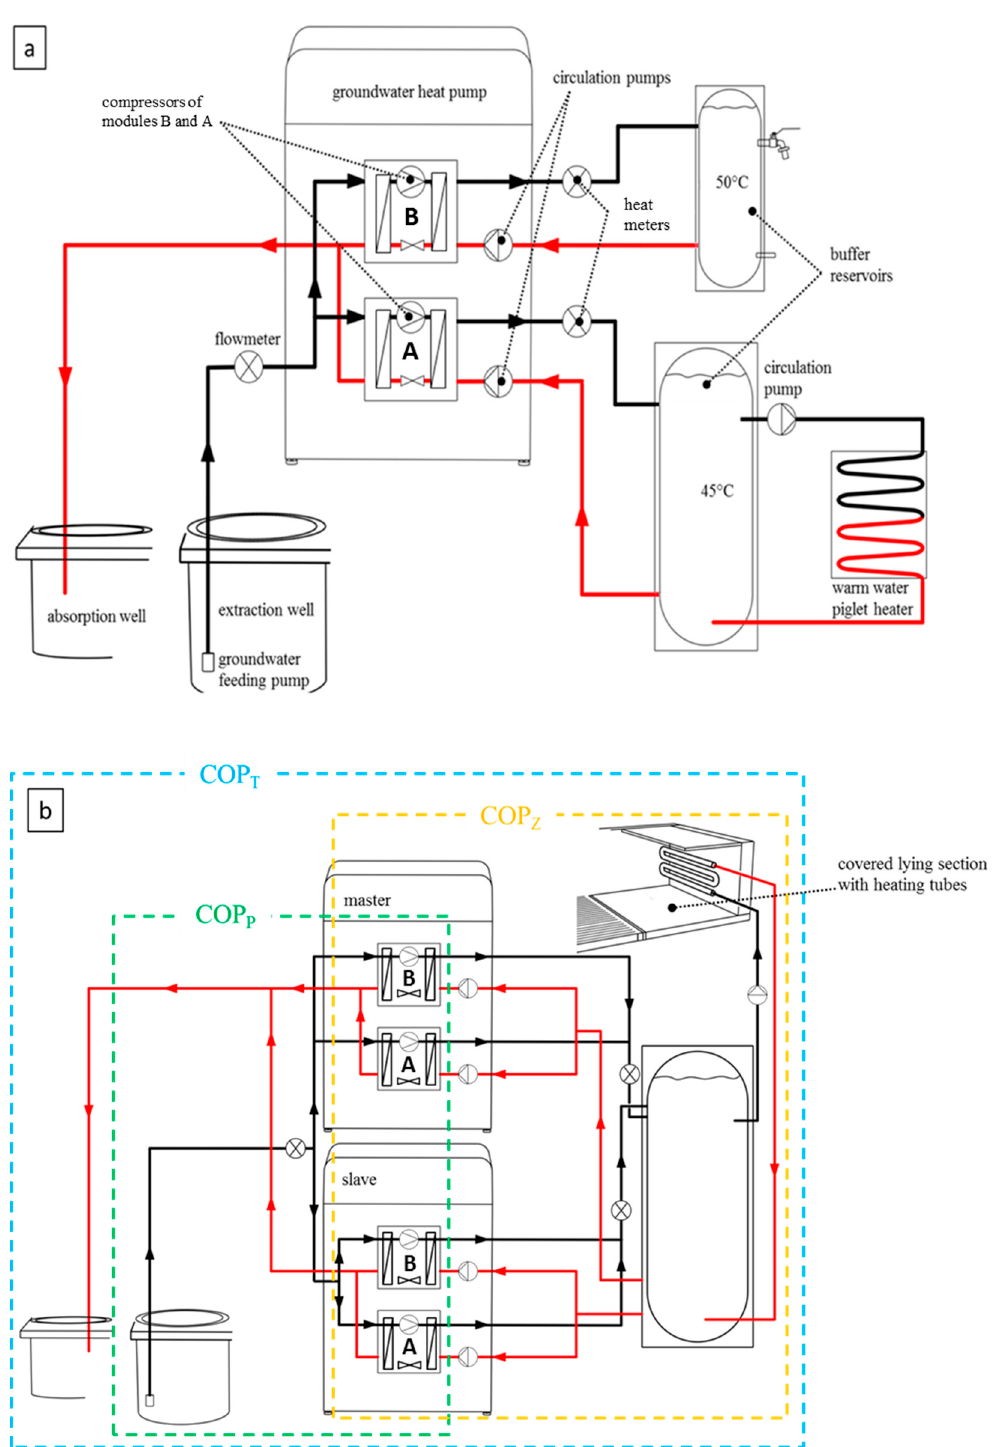
Figure 3. Installation diagram of ( a ) the heat pumps in the farrowing barn with experiment instrumentations and ( b ) piglet-rearing barns with the assessment limits for the determination of the coefficient of performance (COP).